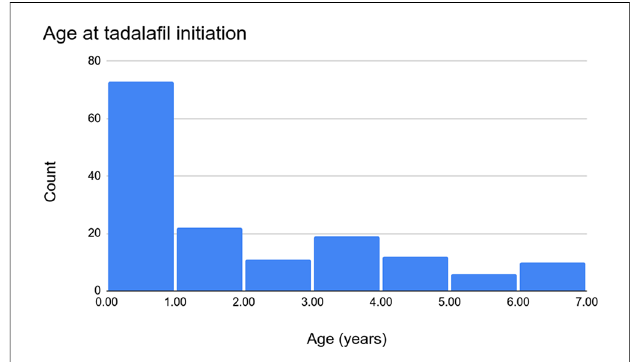
FIGURE 1 Histogram of age at tadala fi l